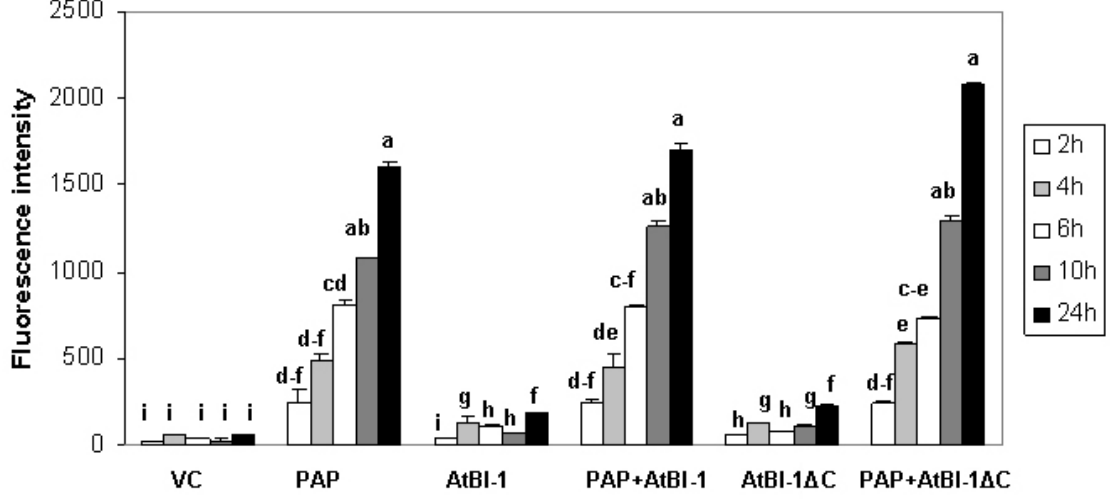
FIGURE 2: ROS generation in cells expressing PAP and AtBI-1. The amount of H 2 O 2 production was quantified using DCDHF-DA. The results are represented as the means ± standard deviation (n=3). VC - vector control. The results represent three independent experiments. Col- umns are statistically different according to ANOVA (P < 0.001) followed by a post-hoc Fisher's Least Significant Difference (LSD)